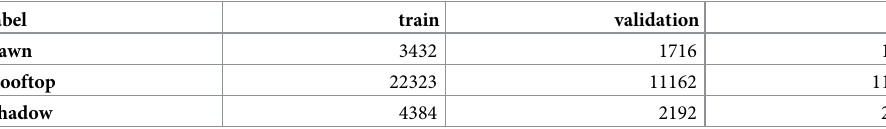
Table 2. Splits of train, test, and validation samples for Urban dataset.